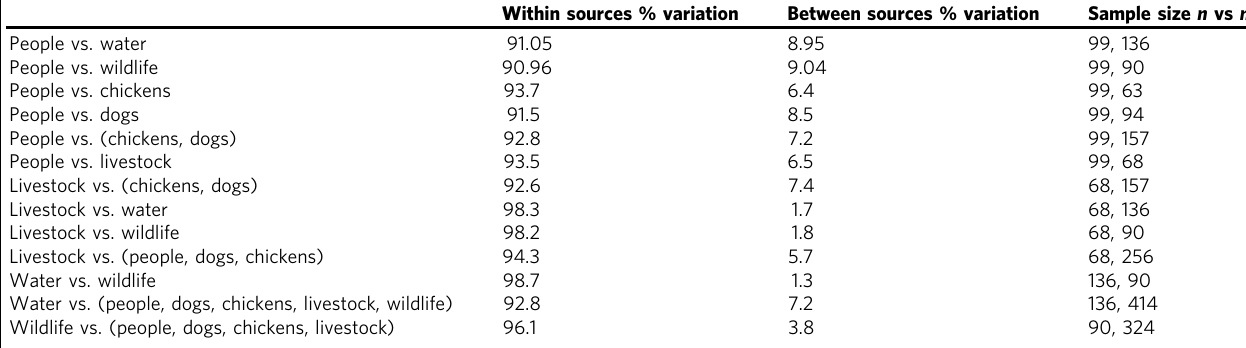
Table 3 The distribution of E. coli haplotypes within and between different sources. Within sources % variation Between sources % variation Sample size n vs n People vs.